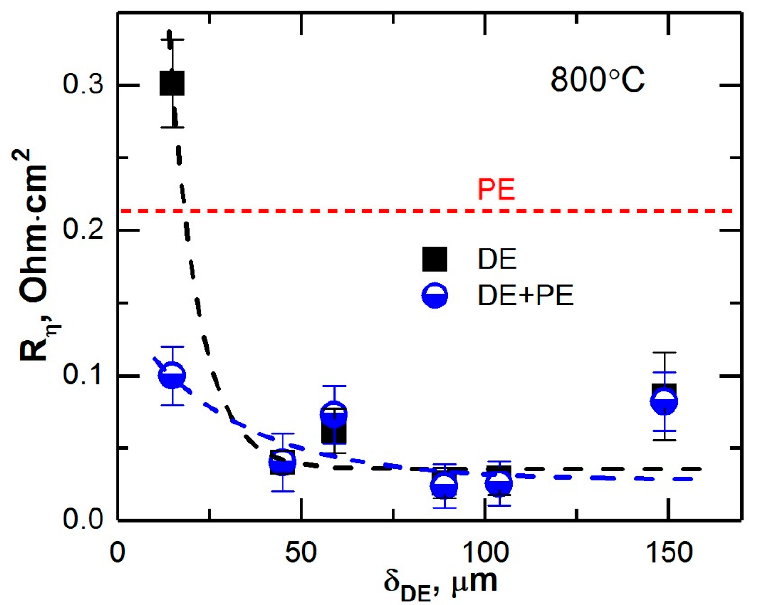
Figure 6. Dependence of the polarization resistance of the electrodes with DE and DE + PE structures on the dense layer thickness. Table 3. Structure of symmetrical samples studied in the oxygen pump mode.